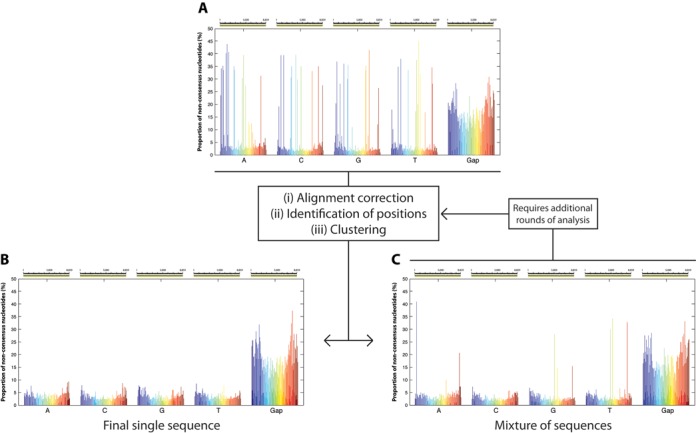
Stepwise classification of reads. Because a majority of the errors generated during sequencing are INDELS, by analyzing the data independently by nucleotide (A, C, G, T), it is possible to reduce the effective background error rate and more accurately identify the positions exhibiting real diversity (A). By implementing a clustering analysis only on positions of the alignment exhibiting significant diversity, so that two groups are generated at every step, it is possible to eventually obtain a subgroup of reads that lack any evidence of diversity (B). Such homogeneous subgroups can be considered to be the result of sequencing DNA molecules with the exact same nucleotide sequence. Some subgroups require further analysis to derive additional subgroups as they remain a mixture of multiple sequences (C).